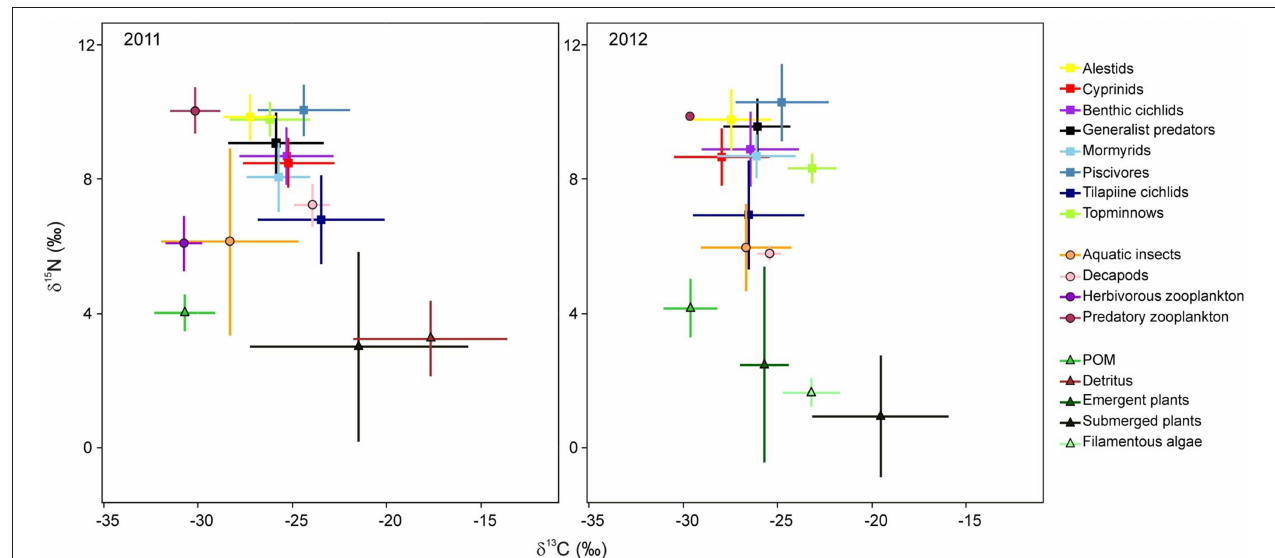
FIGURE 2 | Stable δ 13 C- δ 15 N isotopic bi-plots of fish groups and their potential food sources from Lake Liambezi in 2011 and 2012. Data points represent the mean ± standard deviation for each